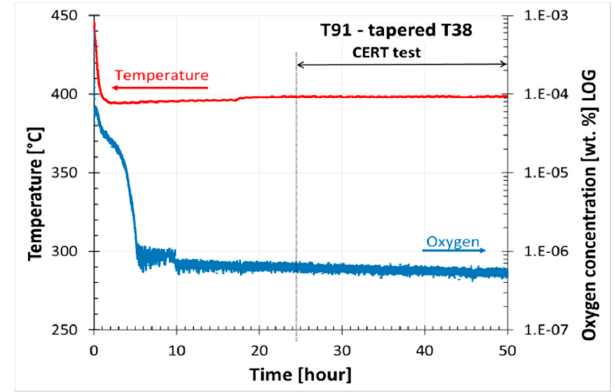
Figure 6. Time dependence of temperature and oxygen concentration in liquid Pb during CERT tests: Tapered specimens ( a ) T36; ( b ) T37; and ( c ) T38. Time started from the filling of the second (test) tank with Pb. The vertical line marks the CERT test start and the arrow marks the test duration.